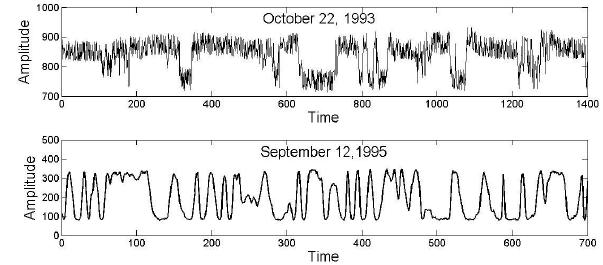
Figure 2. Excerpts of the analyzed time series displaying dichotomous features: a) SES activity in